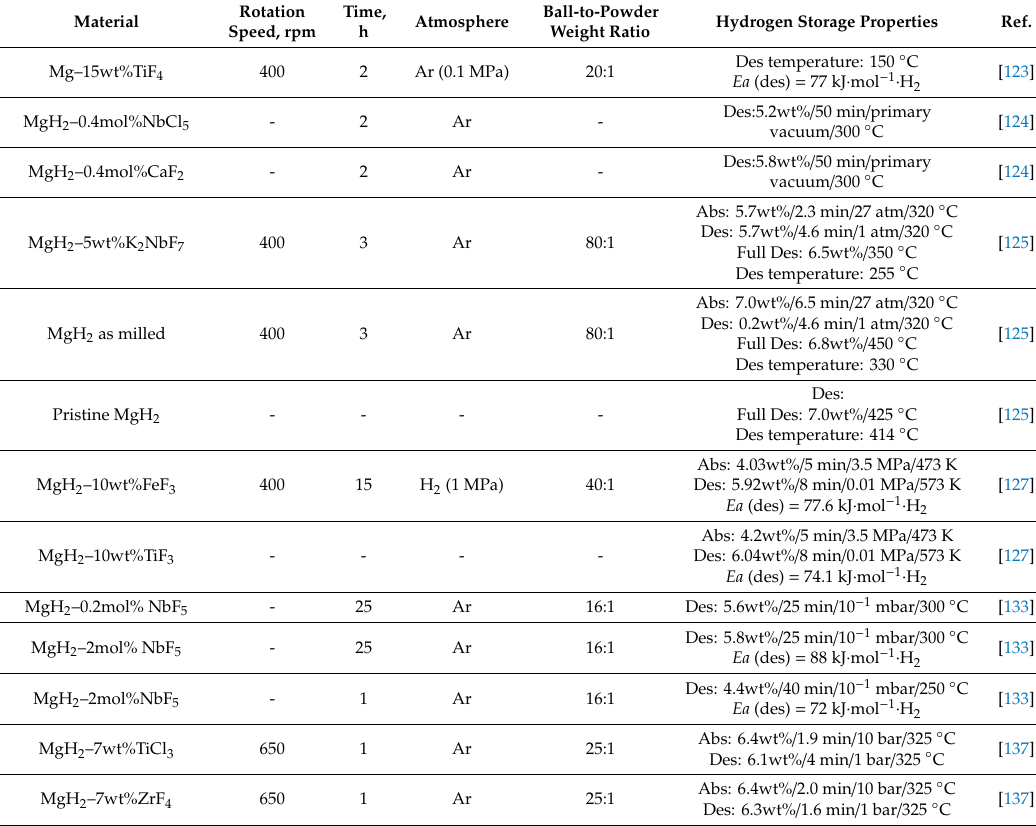
Table 4. Hydrogen storage properties of selected Mg modified by transition metal halide